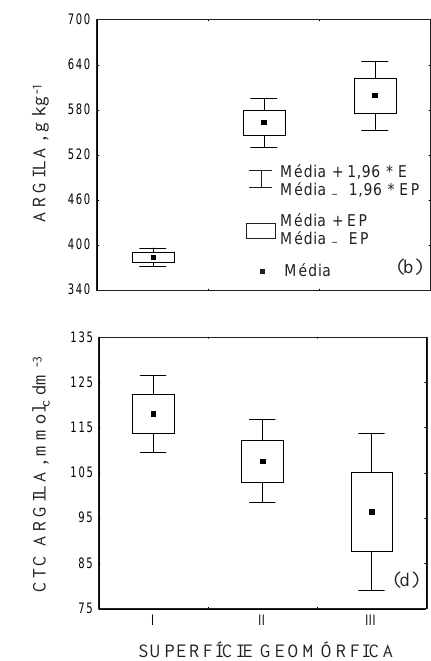
SUPERFÍCIE GEOMÓRFICA SUPERFÍCIE Figura 2. Médias, com respectivos intervalos de confiança, de atributos físicos e químicos dos solos (profundidade de 0,6 a 0,8 m), de acordo com as respectivas superfícies geomórficas: (a) densidade de partículas; (b) teor de argila; (c) CTC do solo; (d) CTC da argila.